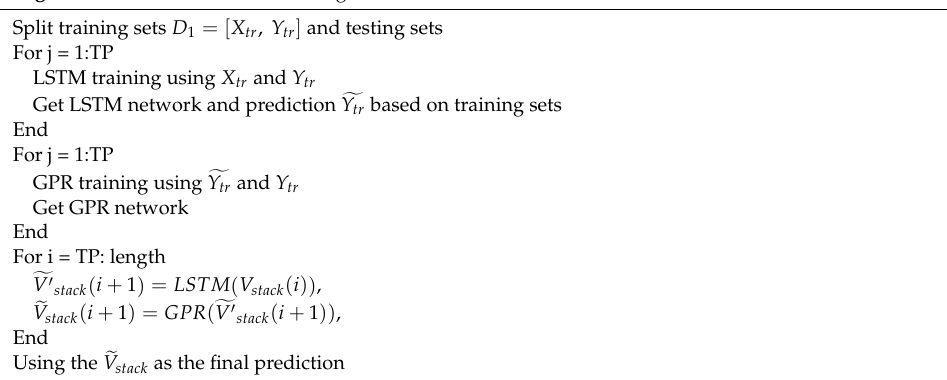
Algorithm 1: LSTM-GPR Method Algorithm